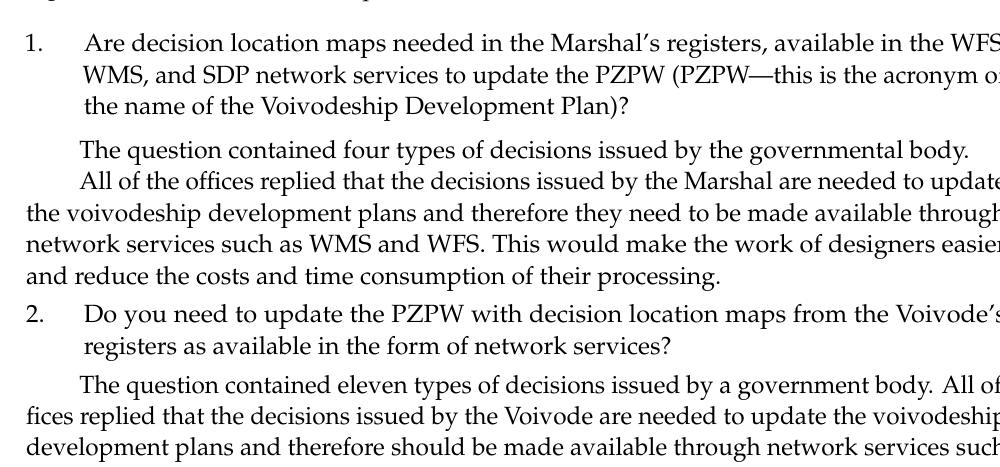
Figure 18. Answers to the fourth question of Unit B.